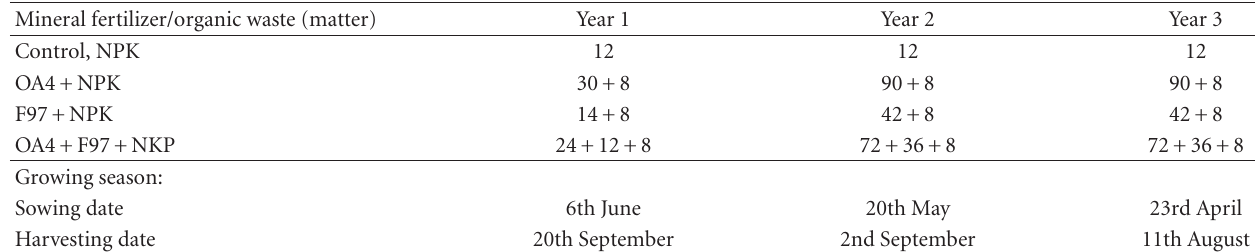
Table 3: Amount of N (gN m − 2 ) applied as mineral fertilizer and organic waste/matter in the lysimeter experiment, and length of growth